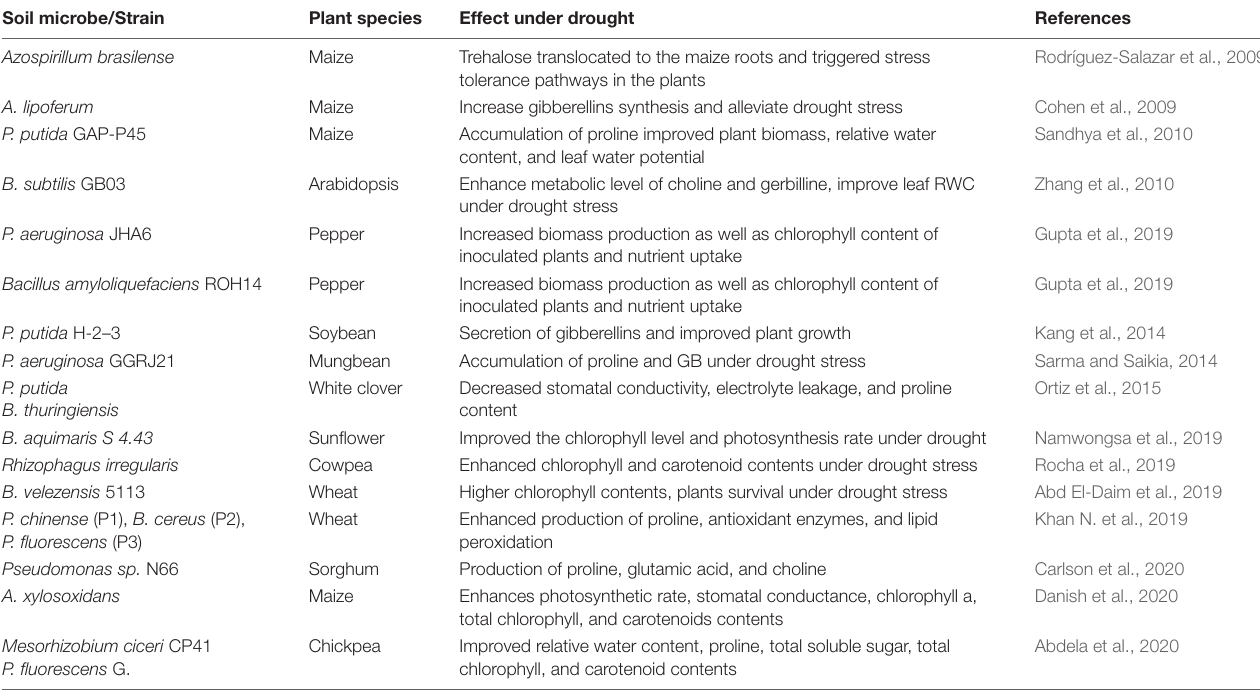
TABLE 2 | Photosynthetic pigments and osmolytes produced by PGPR to mitigate drought stress. Soil microbe/Strain